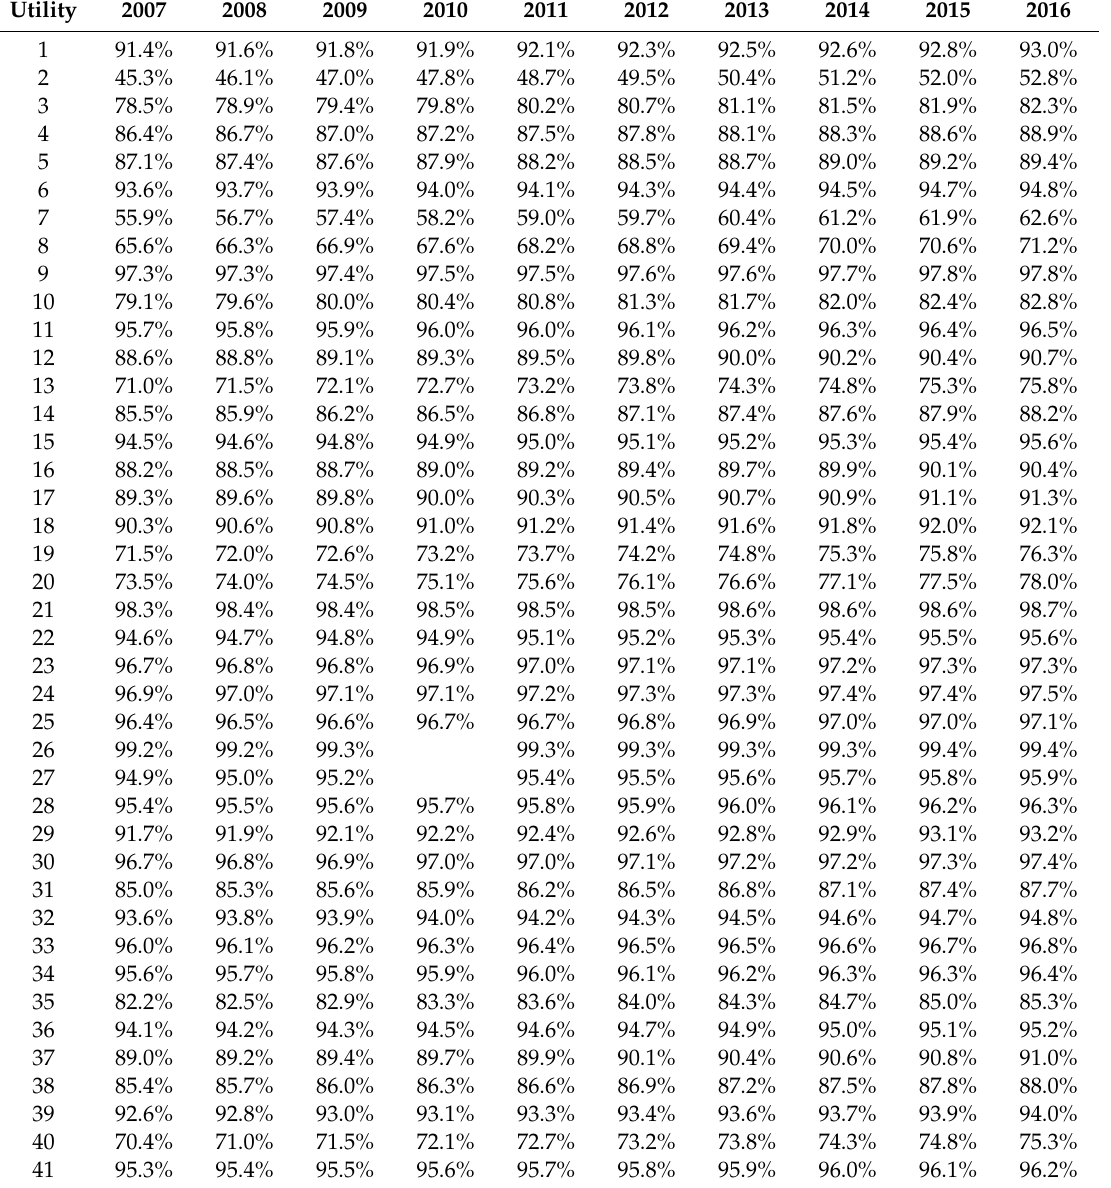
Table A1. E ffi ciencies calculated with the SFA